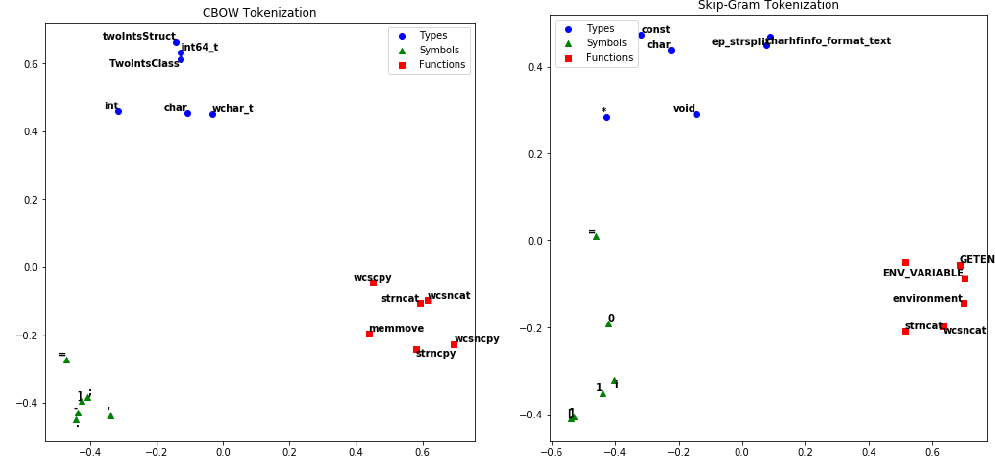
Figure 6. CBOW and Skip-gram tokenization results.